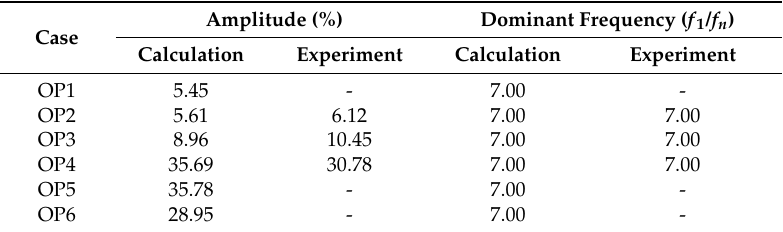
Figure 9. Photograph of a twin vortex rope taken during the experiment, with ropes 1 and 2 labelled.